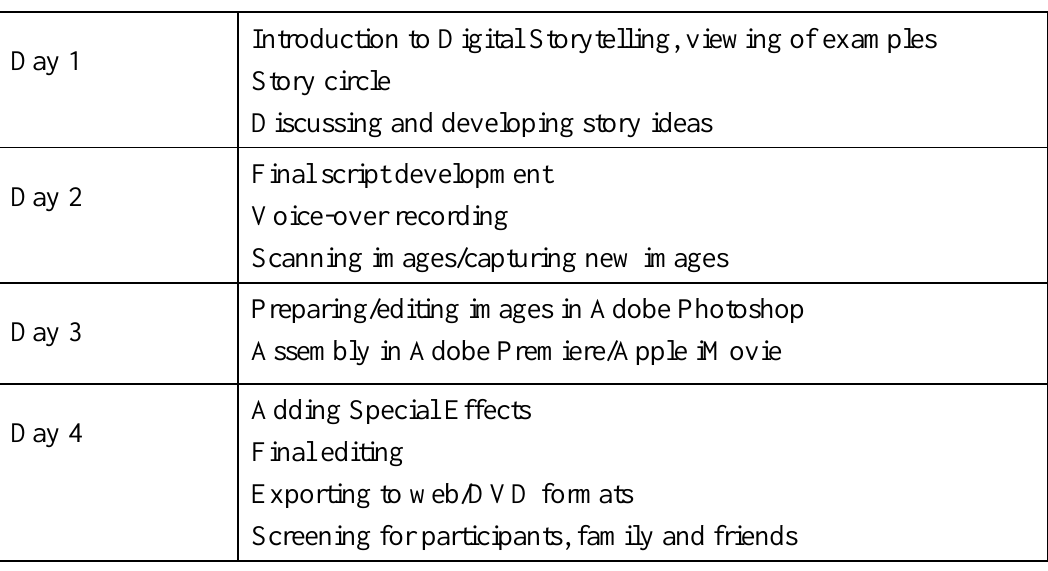
Table 2: Sample Workshop